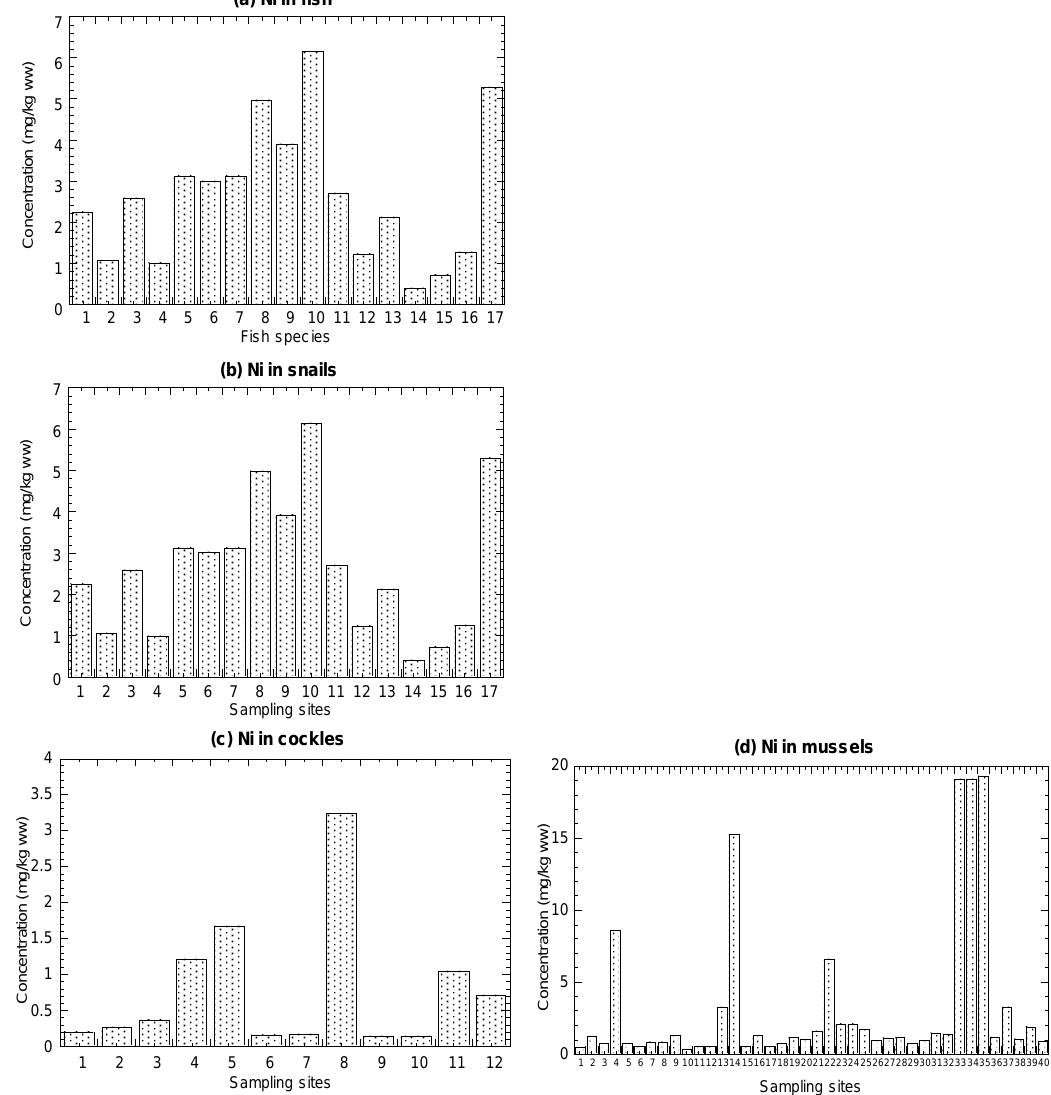
Figure 2. Mean concentrations (mg/kg wet weight (ww)) of nickel (Ni) in the ( a ) marine fish (1 – 19), ( b ) mangrove snail Cerithidea obtusa (1 – 17), ( c ) cockle Anadara granosa (1 – 12), and ( d ) marine mussel